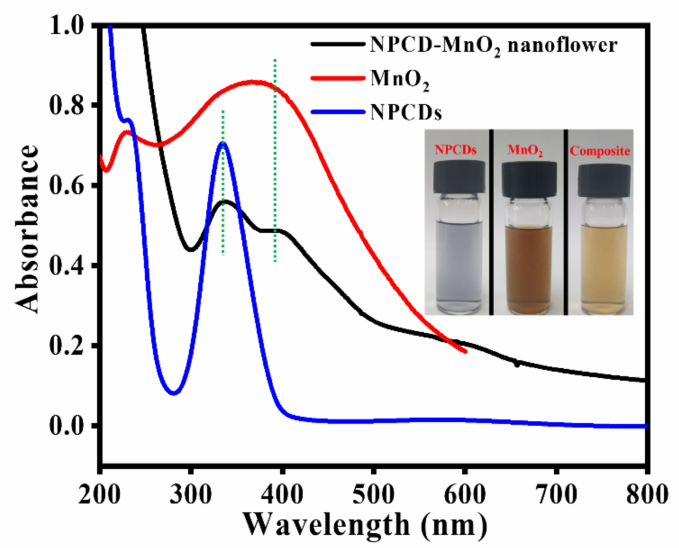
Figure 1. Absorption spectra (inset: aqueous solutions) of NPCDs, MnO 2 , and the NPCD-MnO 2 nanocoral composite.